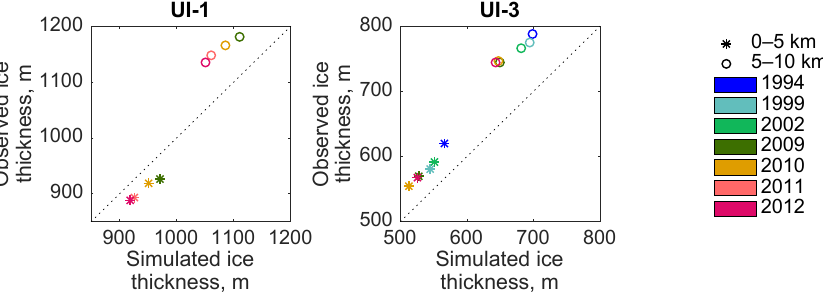
Figure 4. Observed vs. simulated ice thickness along flight lines (IceBridge surface elevation data; Thomas and Studinger, 2010; Krabill, 2010, updated 2016) over UI-1 and UI-3. Stars mark mean values between 0 and 5km from the 2012 terminus, dots refer to mean values 5–10km upstream from the 2012 terminus. Flight lines over UI-1 are available for the years 2009, 2010, 2011, 2012 and over UI-3 in the